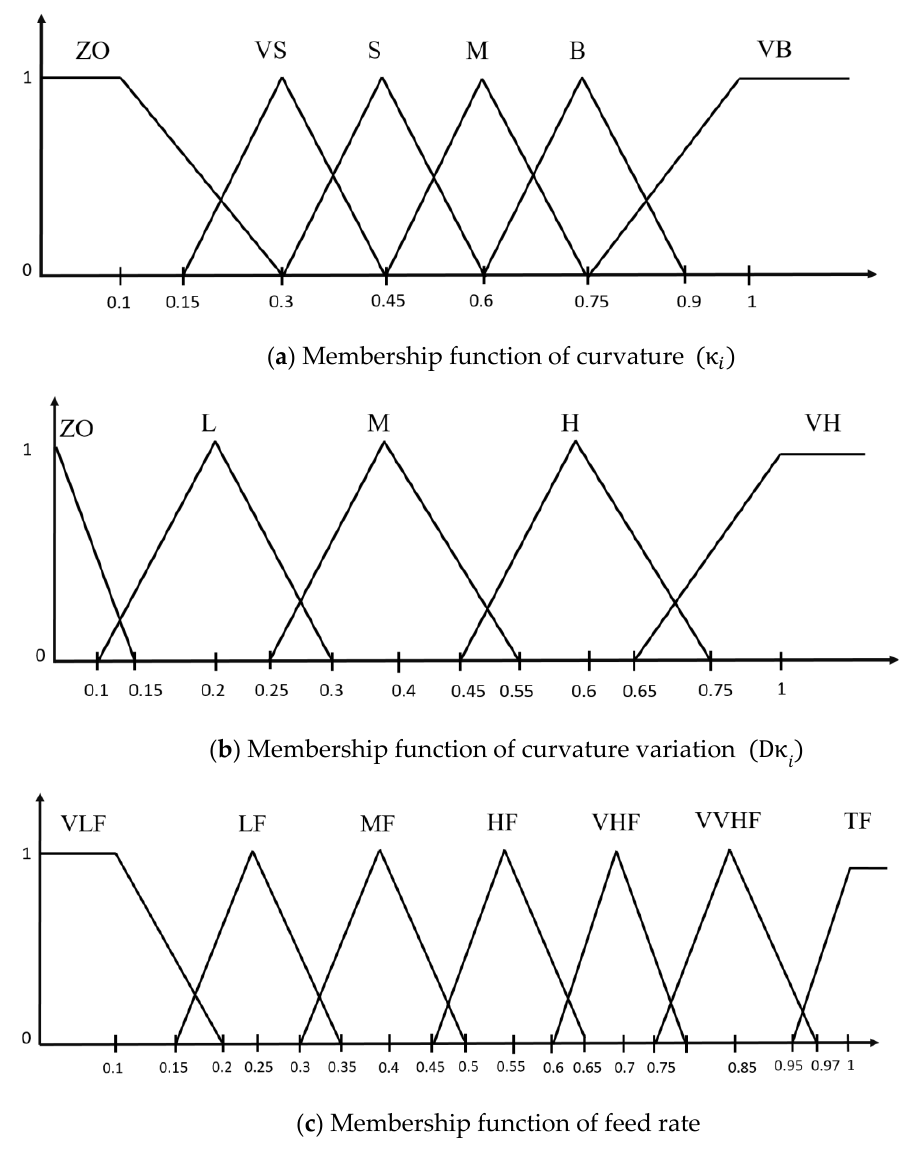
Figure 5. Membership functions of ( a ) curvature, ( b ) curvature variation, and ( c ) feed